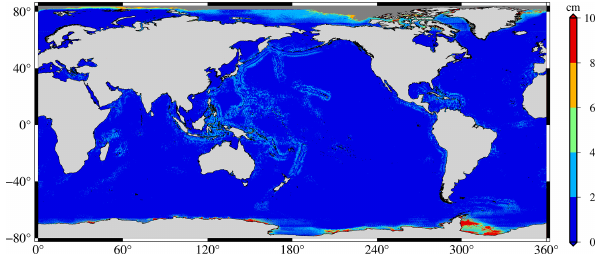
Figure 10. Formal error of the CLS15 model.